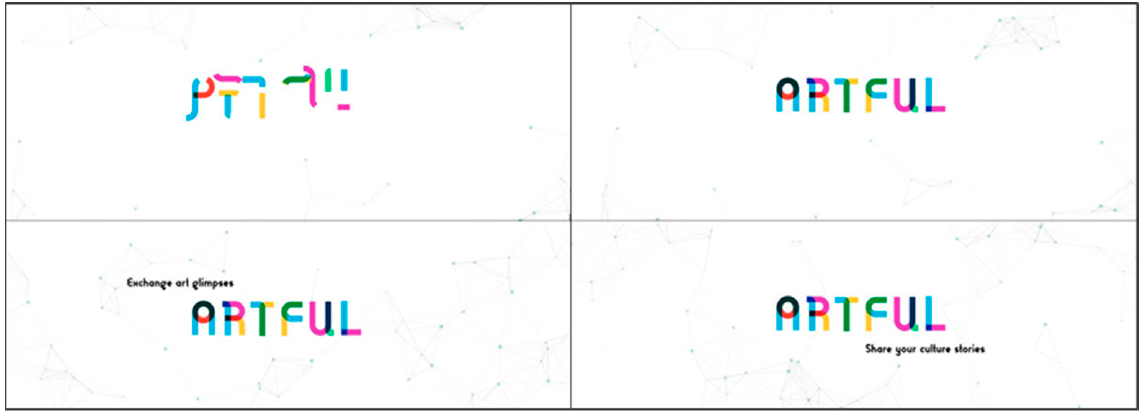
Figure 2. ARtful’s logo presented in the app’s intro video.